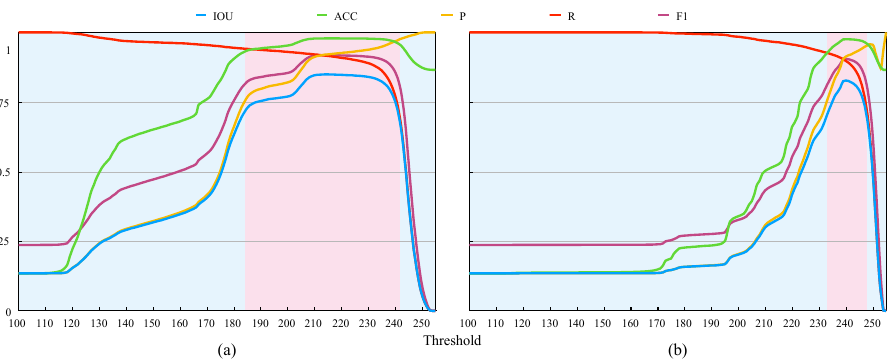
Figure 12. The colour information extraction ability compared with our method: ( a ) our result (WGAN-GP loss and Res-net) and ( b ) the results of the improved method (WGAN loss and Res-net).